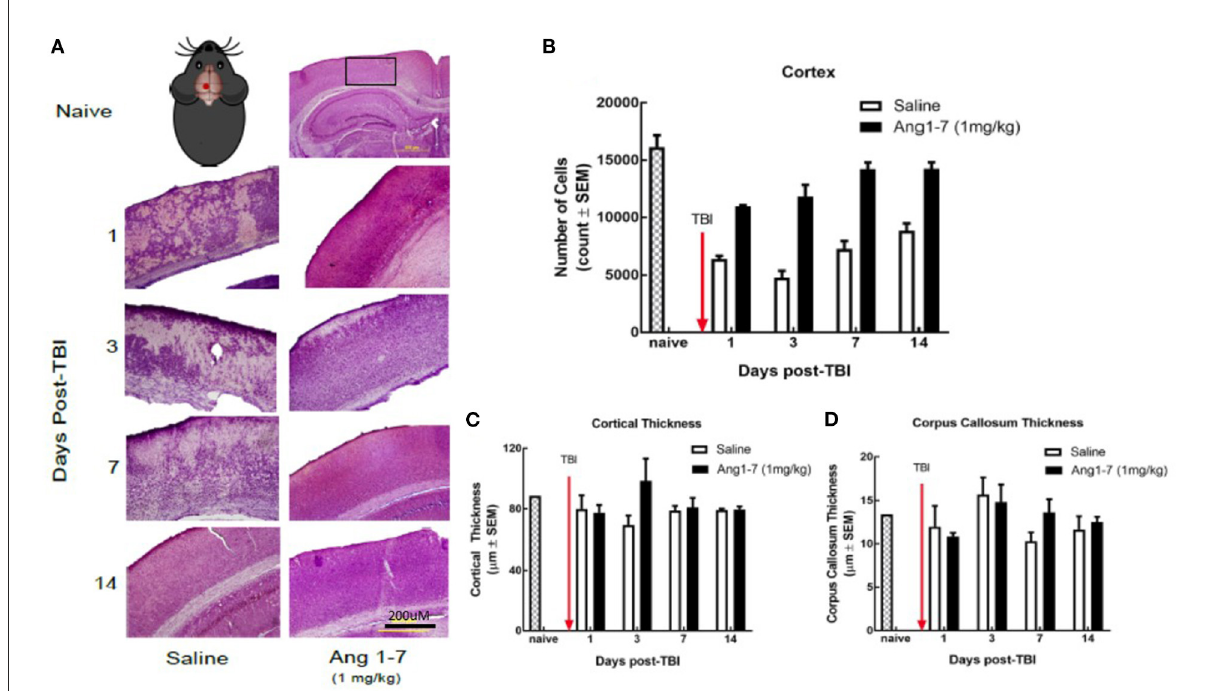
FIGURE4 Histology of cerebral cortex after mTBI and Ang1-7 intervention (A) HandE staining of cortex for naïve, saline ( N = 4), and Ang-(1-7) ( N = 4) treated groups days 1, 3, 7, 14 post-TBI. (B) Mouse picture gives location of the single mTBI to the closed skull just above the left parietal lobe . Ang-(1-7) (1 mg/kg, i.p./day on days 1–5) treated mice have significantly higher cortical cell count compared to the saline-treated mice (days 1–5, i.p. p < 0.03). (C,D) No significant difference was found for cortical thickness and corpus callosum thickness between Ang-(1-7) (1 mg/kg, i.p./day on days 1–5) treated mice and saline treated